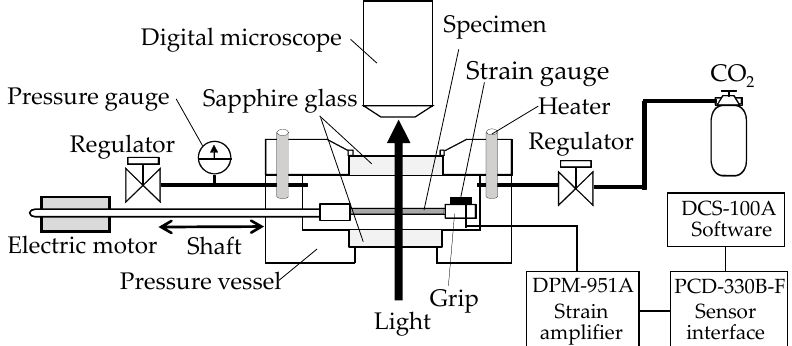
Figure 1. Schematic illustration of a stretching instrument for tensile-deformation measurements and in situ observation under high-pressure CO 2 .